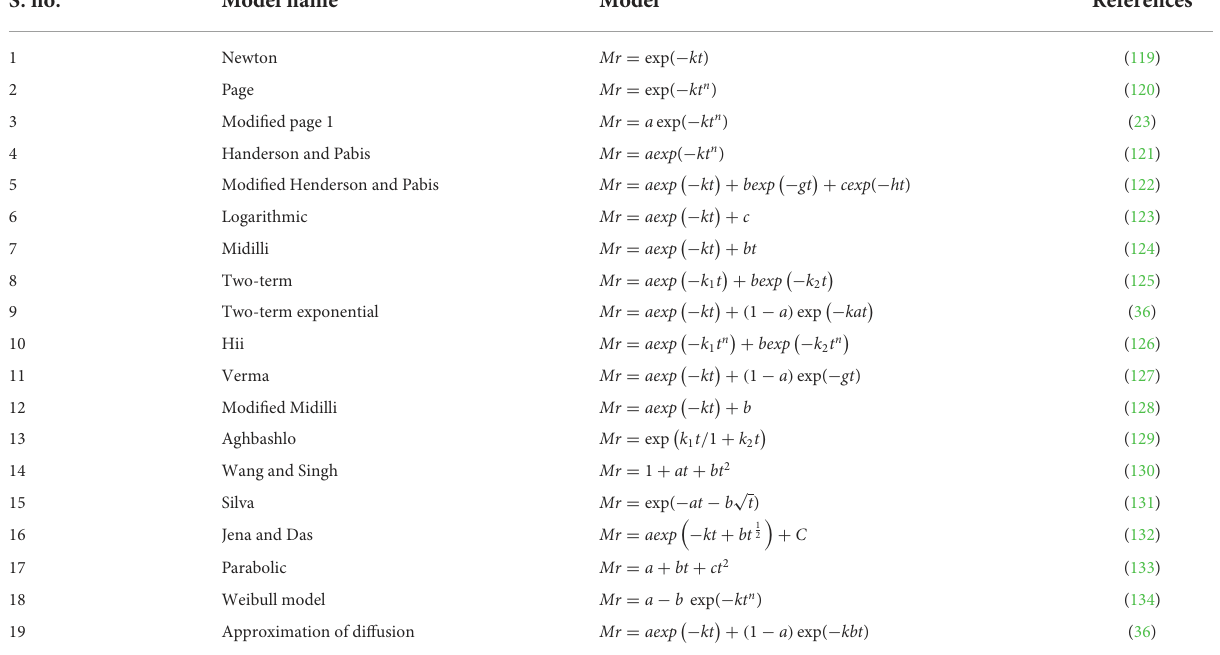
TABLE 5 Thin layer models were reported in previous studies for sweet potato drying. S.